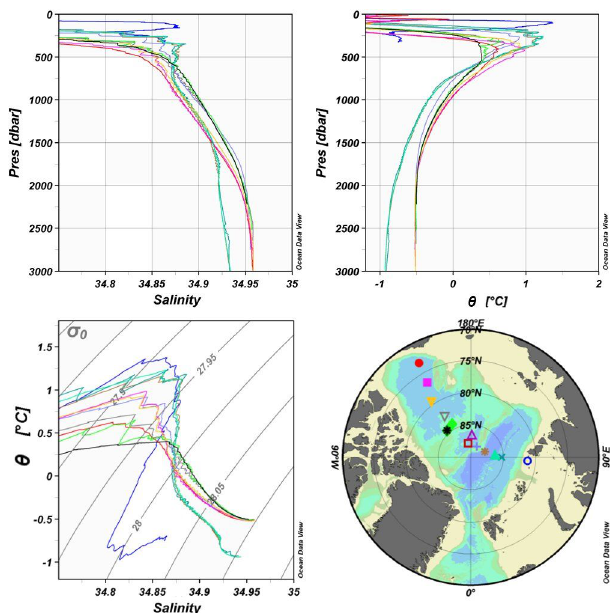
Fig. 14. Potential temperature and salinity profiles and θ S curves comparing the Barents Sea branch characteristics with those found in the other basins. The Barents Sea branch could, at least in princi- ple, supply the Atlantic and intermediate water to the Arctic Ocean Basins beyond the Nansen Basin and the Gakkel Ridge. Data from Polarstern 2007 and Oden